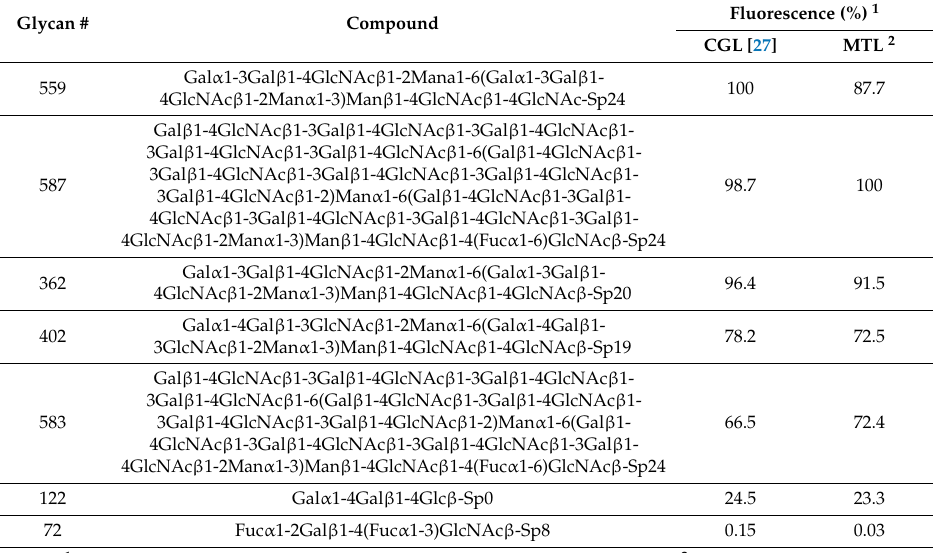
Table 3. The most active ligands from the CGL and MTL microarray